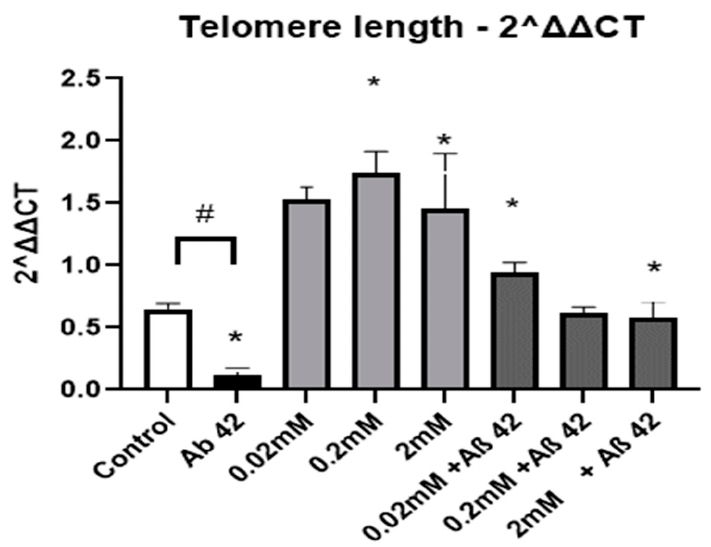
Figure 2. Estimates of telomere length in primary cultures of rat cortical neurons treated with different concentrations of lithium (0.02 mM, 0.2 mM and 2 mM) and neurons co-treated with lithium chloride and A β 1-42 (5 µ M). The experimental controls are depicted by the leftmost (white) bar, indicative of untreated neurons, and the black bar represents the positive control for A β 1-42 toxicity (83% reduction in telomere length compared to untreated controls). Light gray bars indicate the effect of lithium treatment alone on telomere length as compared to untreated controls. Dark gray bars refer to the effect of lithium in neurons challenged with fibrillary A β 1-42 , as compared to the positive control, showing 136% and 179% increase in telomere length in neurons pre-treated with 0.02 mM and 0.2 mM lithium, respectively. ∆∆ CT, # p < 0.05 vs. control, * p = 0.05 vs. A β 1-42 . The raw data are described